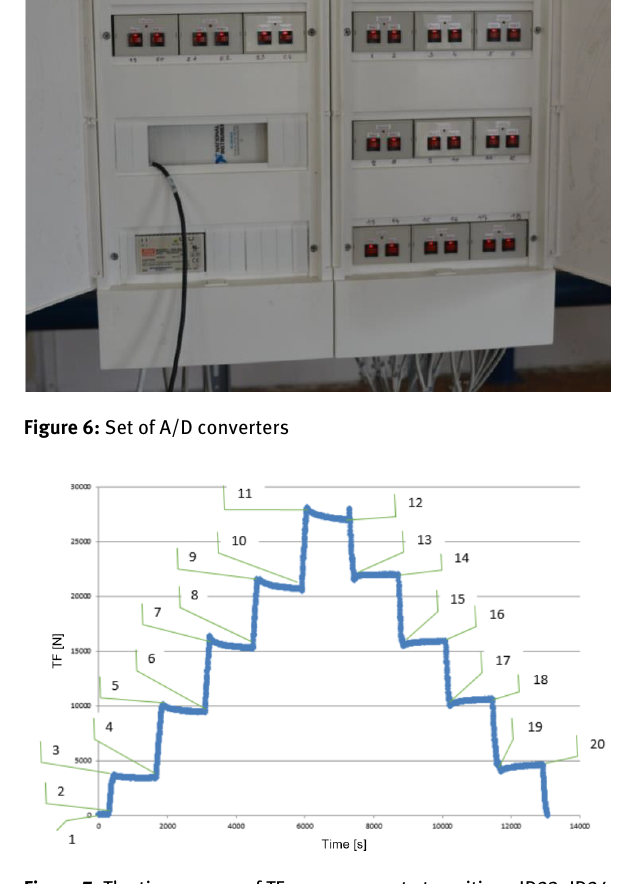
positions ID23 and ID24. The position of straing gauges on all three idler housings is shown in Figure